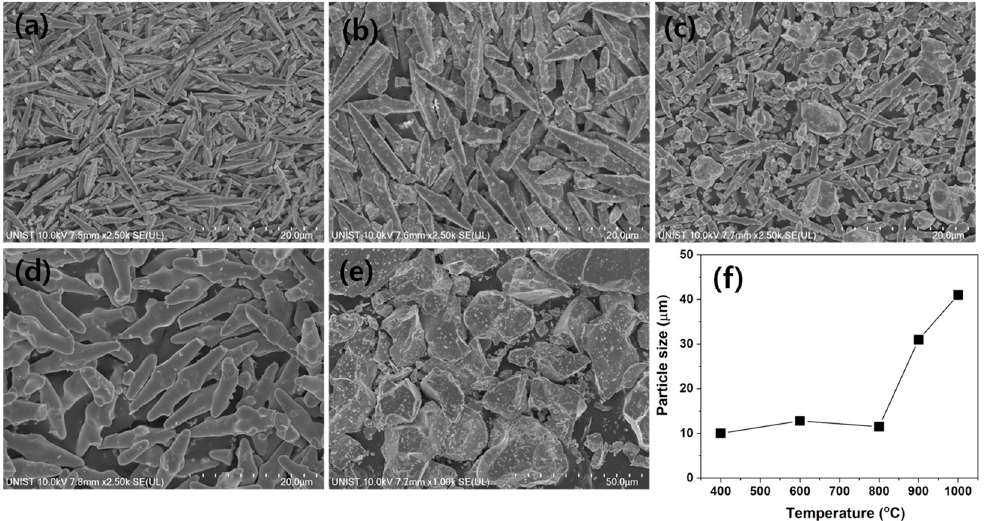
Figure 2. FE-SEM images of BaWO 4 powders with various sintering temperatures: ( a ) 400, ( b ) 600, ( c ) 800, ( d ) 900, ( e ) 1000 ◦ C, ( f ) particle size.